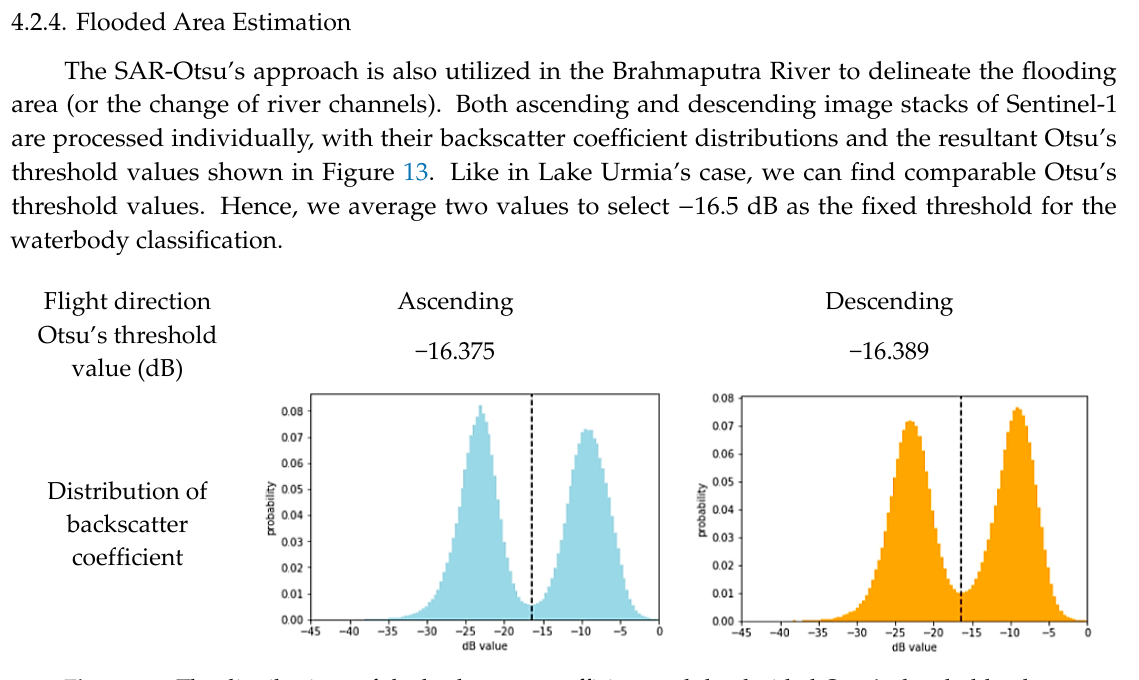
Figure 13. The distributions of the backscatter coefficient and the decided Otsu’s threshold values of the ascending and descending of Sentinel-1 SAR imagery for mapping the flooded area of the Brahmaputra River.